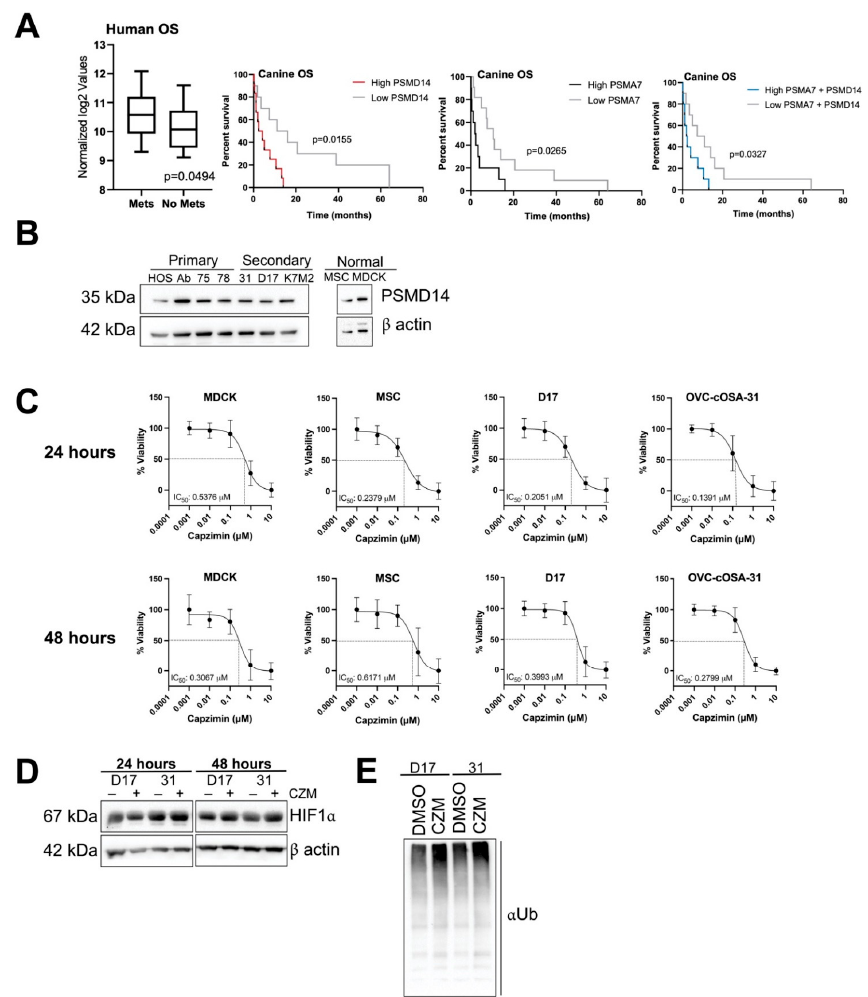
Figure 3. PSMD14 is a clinically relevant and viable target in OS. ( A ) Significant association between PSMD14 mRNA levels in treatment-naïve biopsies and the development of metastasis within 5 years (GSE21257, unpaired t -test). Significant difference in survival between canine OS patients with high versus low PSMD14 and PSMA7 mRNA, alone and combined (GSE27217, log-rank (Mantel-Cox) test). ( B ) Levels of PSMD14 in primary tumour-derived OS cell lines: HOS, Abrams (Ab), OVC-cOSA-75 (75), OVC-cOSA-78 (78), secondary tumour-derived OS cell lines: OVC-cOSA-31 (31), D17, K7M2, and non-malignant mesenchymal stromal cells (MSC) and Madin-Darby canine kidney (MDCK) cells. ( C ) MDCK, MSC, D17 and OVC-cOSA-31 cells were treated with capzimin at 0.001, 0.01, 0.1, 1, 10 µ M for 24 or 48 h and incubated with resazurin for 8 h before reading the absorbance at 570/600 nm (five technical replicates per treatment). IC 50 curves depict normalized % viability, mean ± SD from n = 3 independent experiments. The IC 50 was determined using a four-parameter variable slope model using Prism 9 software. ( D ) Capzimin (CZM) treatment resulted in a slight increase in HIF1 α levels with treatment. Representative HIF1 α immunoblot after D17 and OVC-cOSA-31 (31) cells were subjected to DMSO ( − ) or their respective CZM IC 50 treatment (+) for 24 h (D17 = 205 nM, 31 = 140 nM) or 48 h (D17 = 400 nM, 31 = 280 nM). ( E ) CZM treatment led to an increase in ubiquitinated proteins 6 h post treatment. D17 and OVC-cOSA cells were treated with DMSO or CZM (D17 = 400 nM, 31 = 280 nM) for 6 h before lysis and adsorption with ubiquilin 1 tandem UBA (TUBE2) beads. Enriched ubiquitinated proteins were detected using an anti-ubiquitin